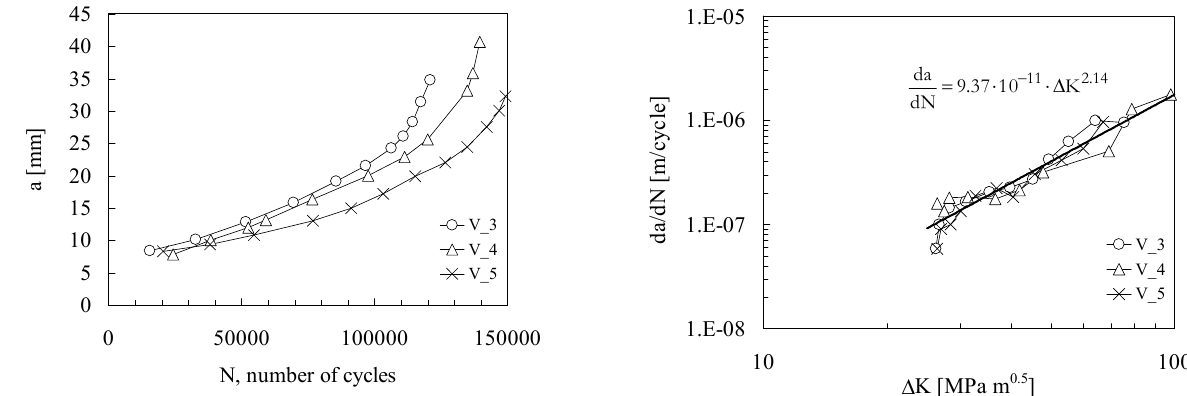
Figure 3: Tension-compression a) crack propagation curves and b) Paris curve of AISI 304 L stainless steel